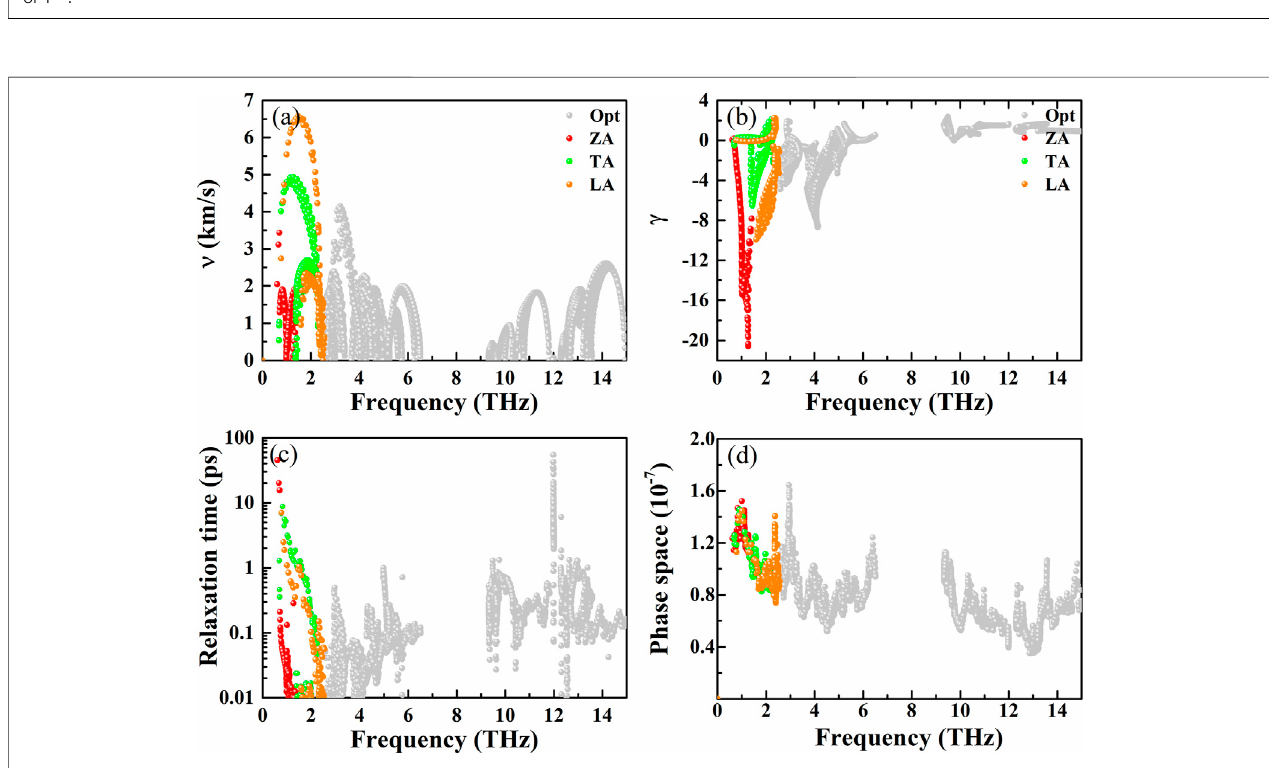
FIGURE 6 | (A) Phonon group velocity, (B) Grüneisen parameters, (C) phonon relaxation time, and (D) three-phonon scattering phase space as a function of frequency for AsP 3 ,